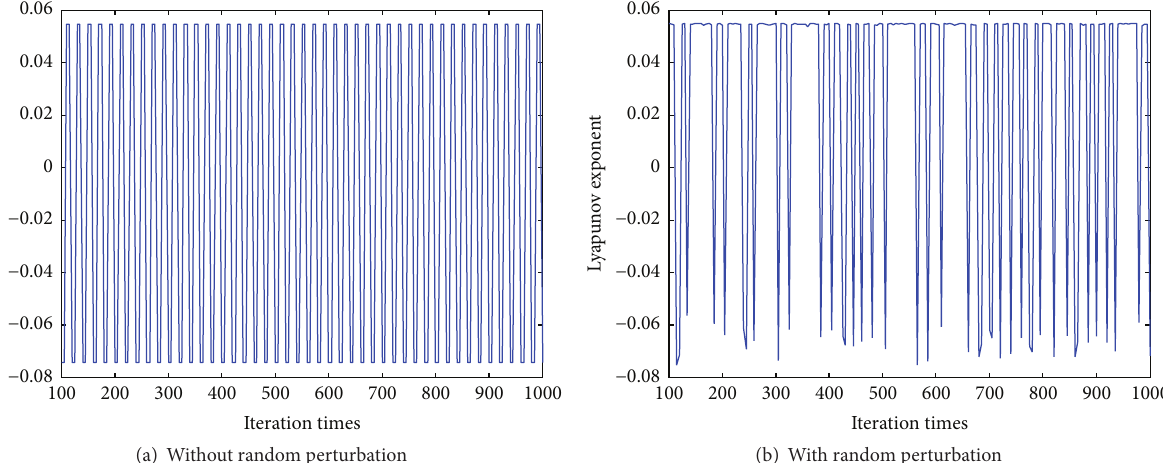
Figure 18: Lyapunov exponents, 𝜔 = 175 .